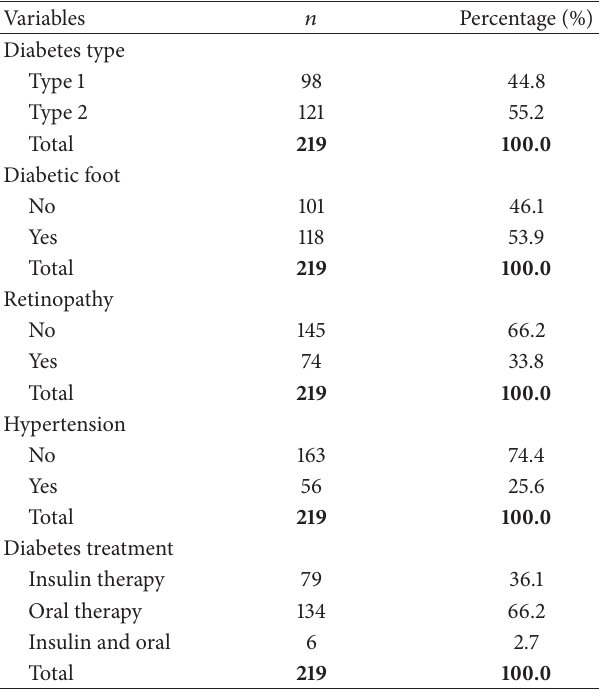
Table 2: Distribution by medical conditions and methods of medication.